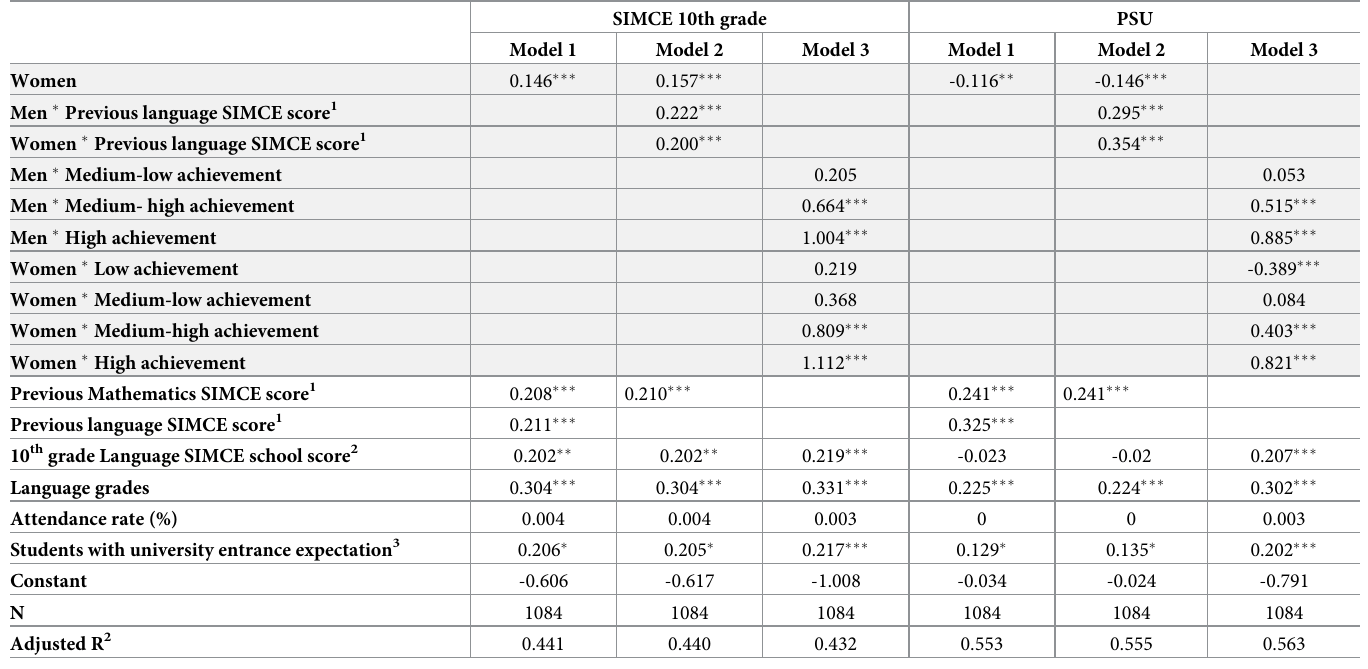
Table 6. Estimated coefficients. Models to predict the performance in language competitive tests (PSU) and noncompetitive tests (10 th grade